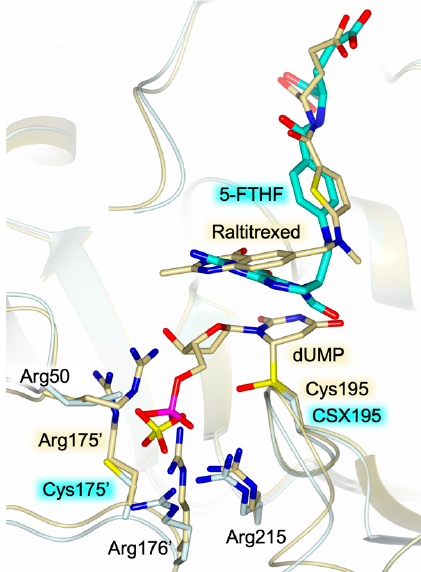
Figure 4. Active site view of the superimposition between the structures of HT-hTS variant R175C